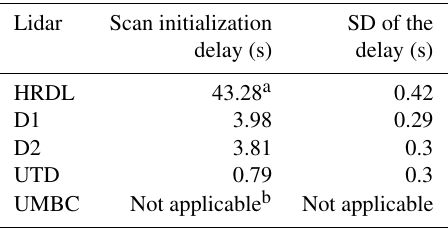
Table 1. Lidar operational parameters. Lidar